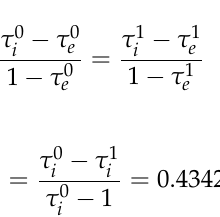
Figure 8. Calculating the dead-time margin τ m of the PID 1 and the T f = T e / n tuning equivalence, n =